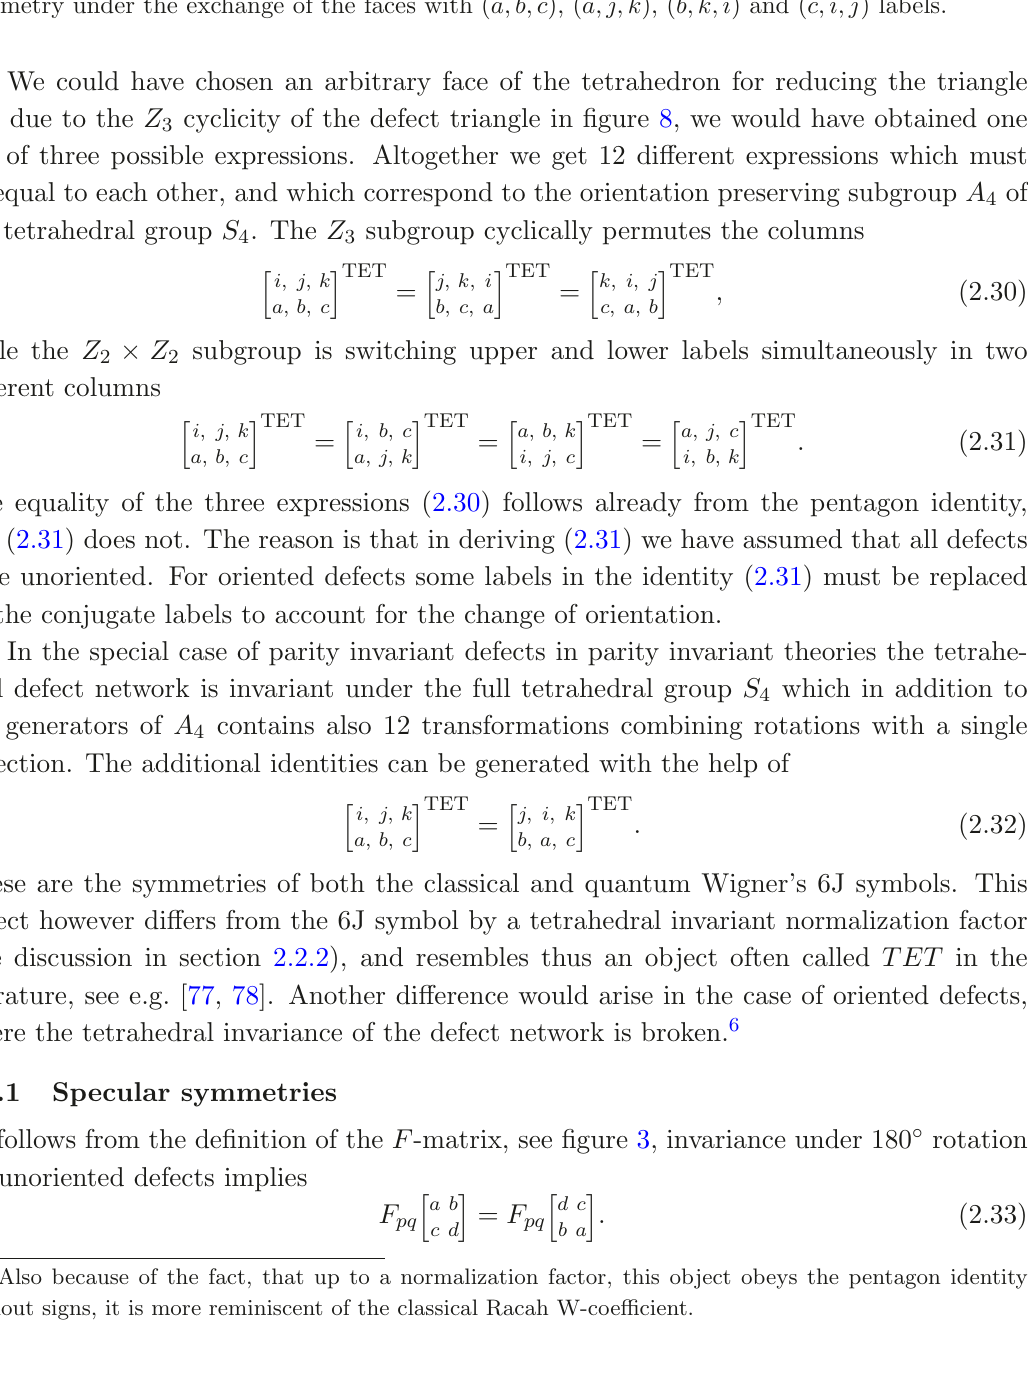
Figure 9 . Tetrahedral defect network. When no operators are present inside the faces, the topo- logical tetrahedron can be shrunk to zero size, yielding a numerical factor with S 4 permutation symmetry under the exchange of the faces with ( a, b, c ), ( a, j, k ), ( b, k, i ) and ( c, i, j )